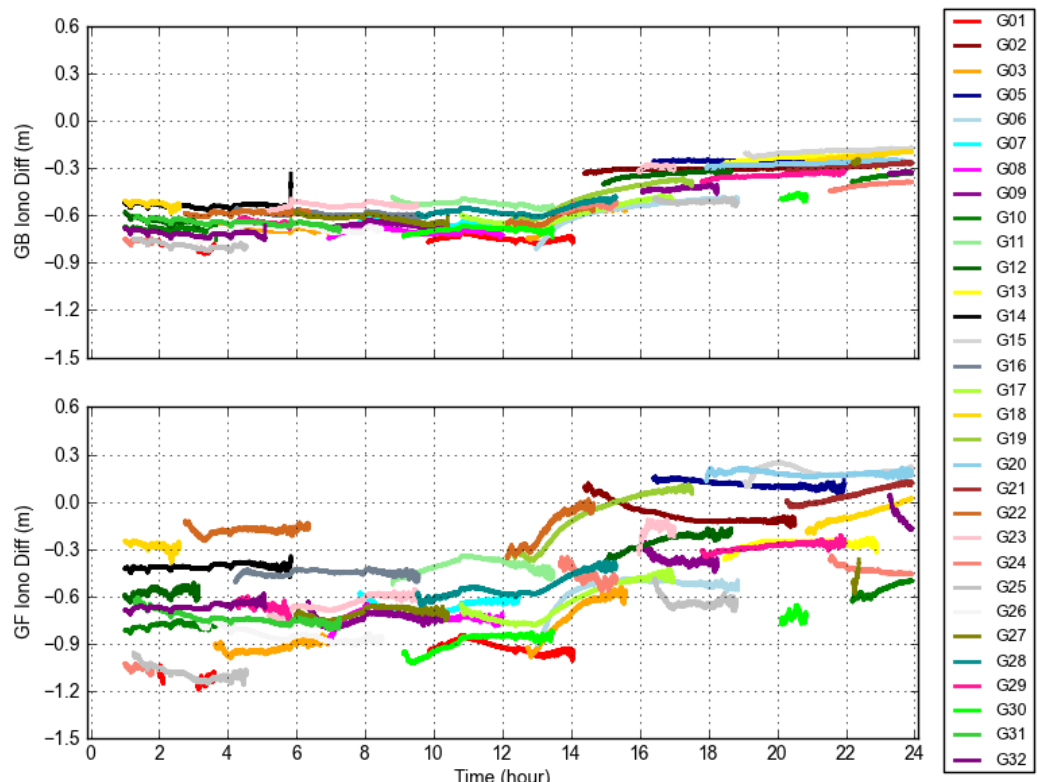
Figure 9. GB ionospheric delay differences ( top ) and GF filtered ionospheric delay differences ( bottom ) between the receiver GODZ and GODN.